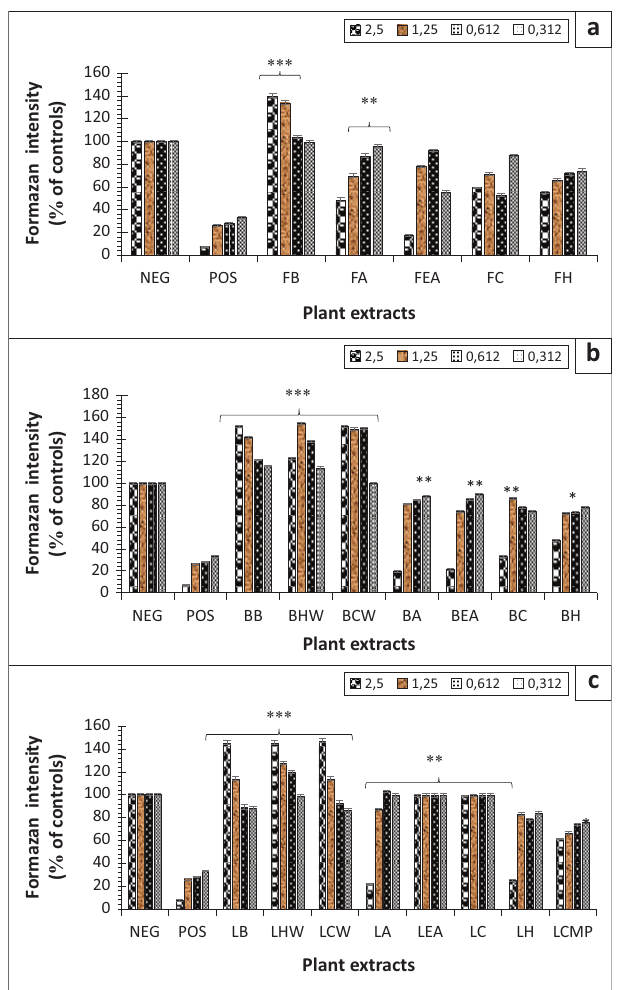
FIGURE 5: MTT assay on 3T3-L1 (preadipocytes) cells, cells treated with C. grandicalyx bark, leaves and fruits extracts for 24 h with H control.